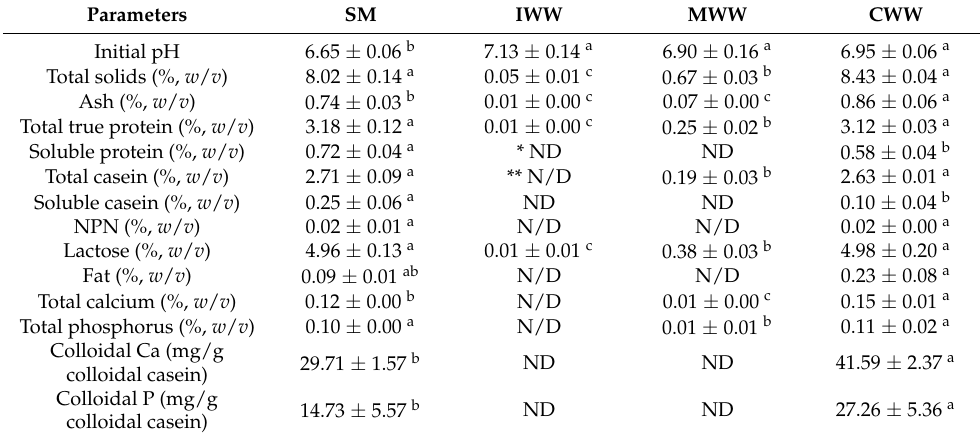
Table 2. Overall chemical composition of skim milk and white wastewater used for cheese-making.